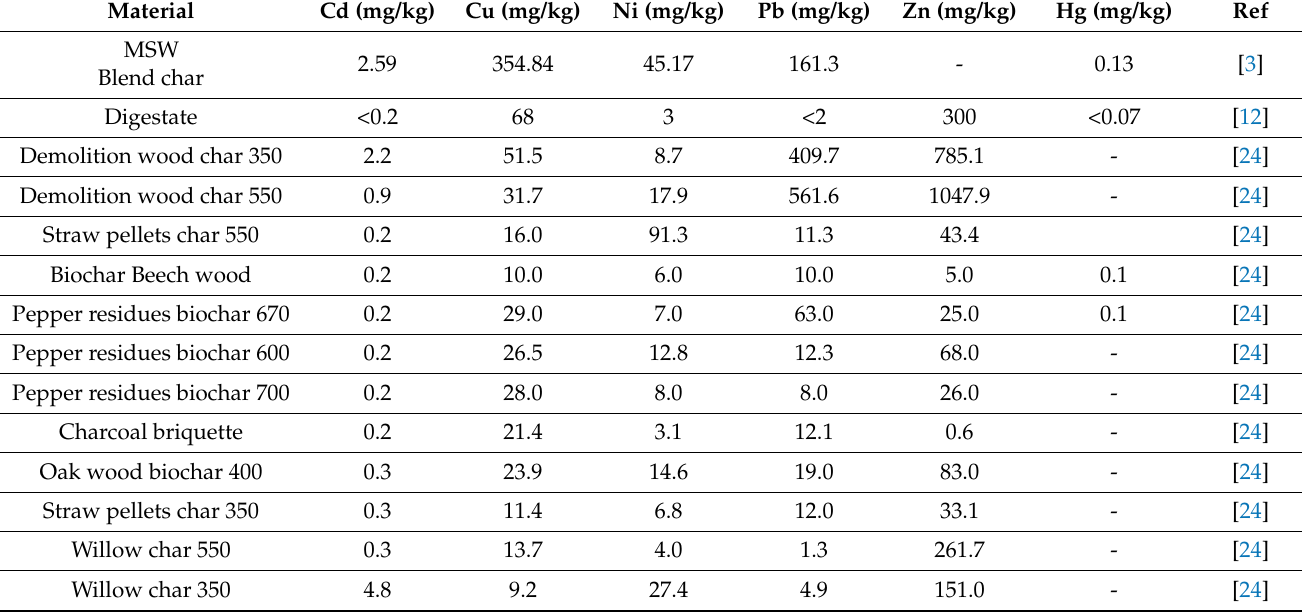
Table 3. Heavy metals in chars obtained from different